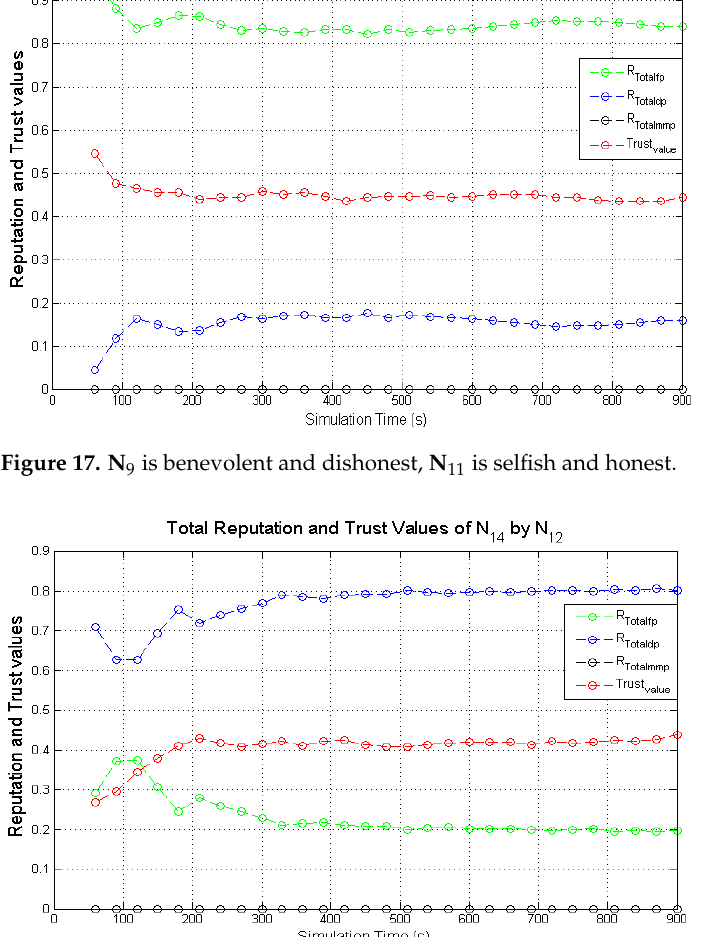
Figure 18. Nodes N 12 and N 14 are both selfish and dishonest.